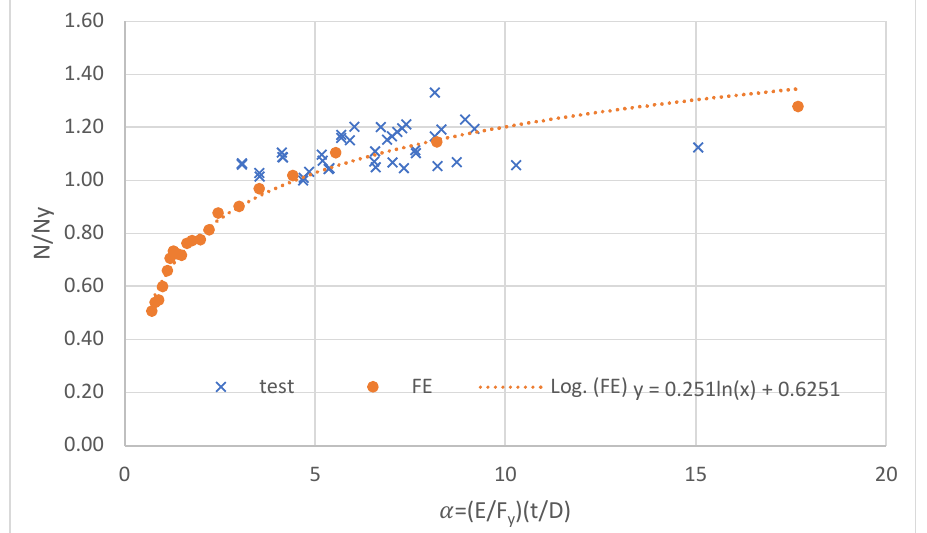
Figure 16. The relation between normalized axial compression and non-dimensional buckling parameter ( 𝛼 ) of S1100 of experimental results by others and FE by the authors for UHSS-S1100.